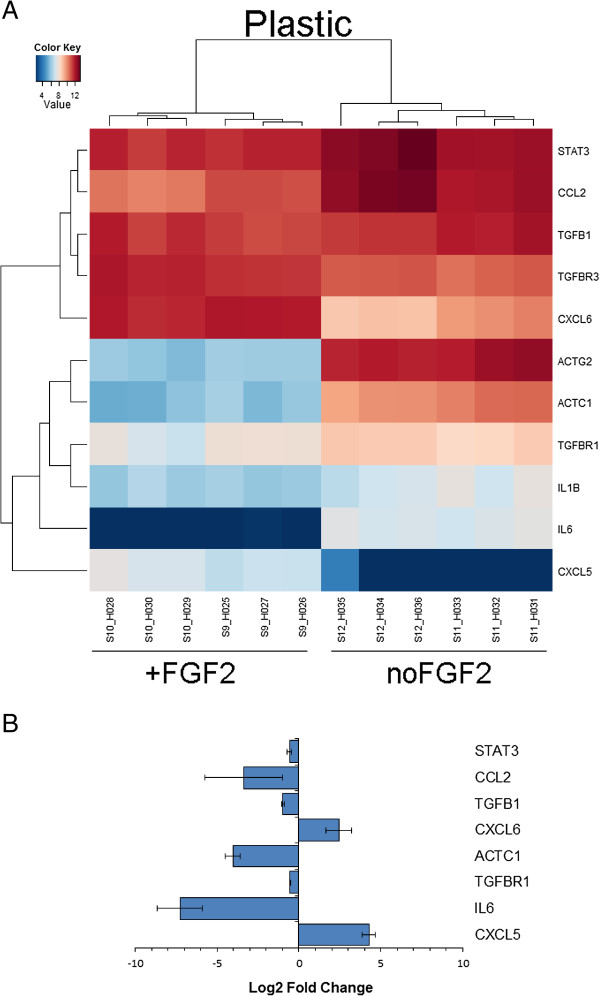
FGF2 affects expression levels of cytoskeleton genes and chemokines. A. Heat map showing expression levels of select genes as identified by microarray analysis. B. qRT-PCR validation of microarray data for select genes. Expression levels were normalized to ACTB and are represented as log2 Fold change (FGF2-treated compared to untreated). Error bars represent SEM. qRT-PCR for IL1B, ACTG2, and TGBR3 did not show change in the expression levels.